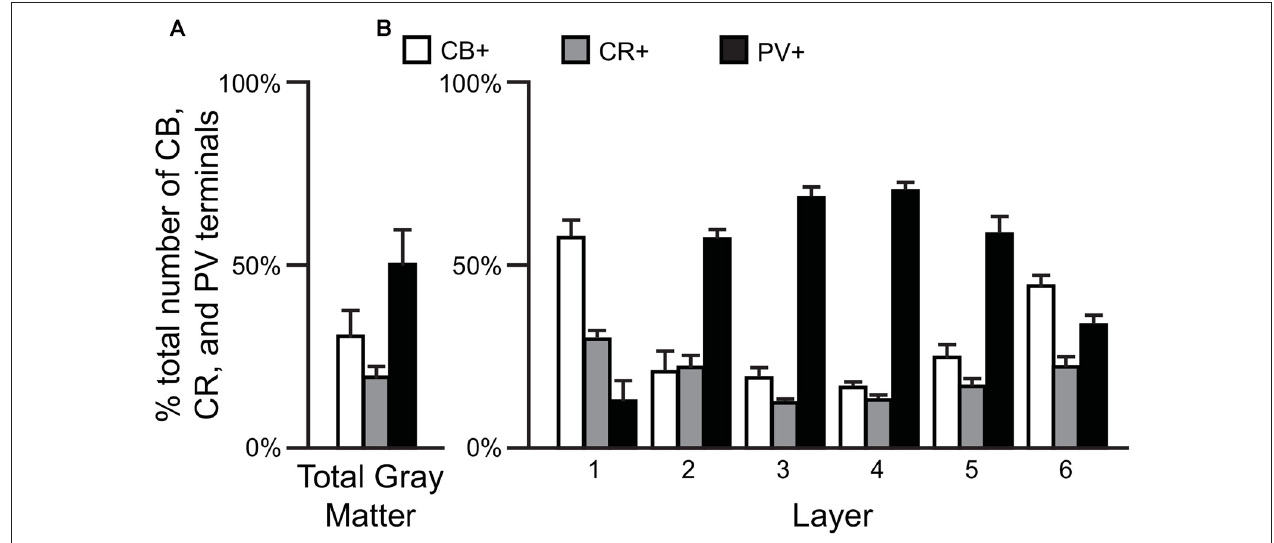
FIGURE 1 | The proportion of GABAergic calbindin+ (CB+), calretinin+ (CR+) and parvalbumin+ (PV+) terminals differs across cortical layers. (A,B) Bar graphs showing the relative proportions of vesicular GABA transporter (vGAT) terminals in prefrontal cortex (PFC) that were CB+, CR+ or PV+. Error bars = SEM.